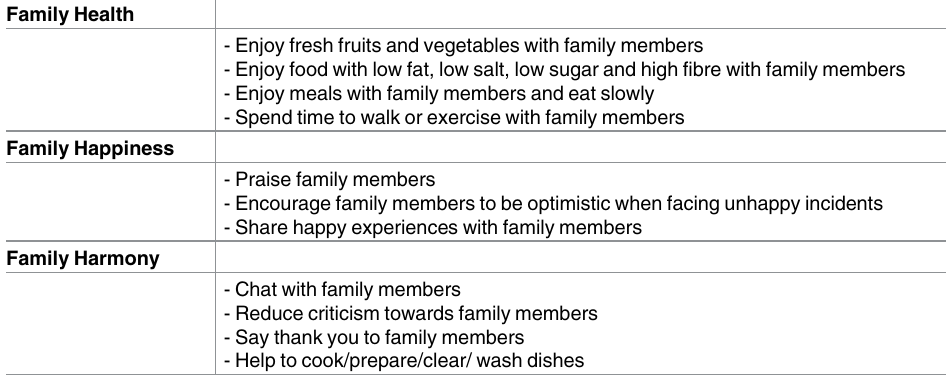
Table 3. Examples of behaviours to promote in order to enhance family well-being. Family